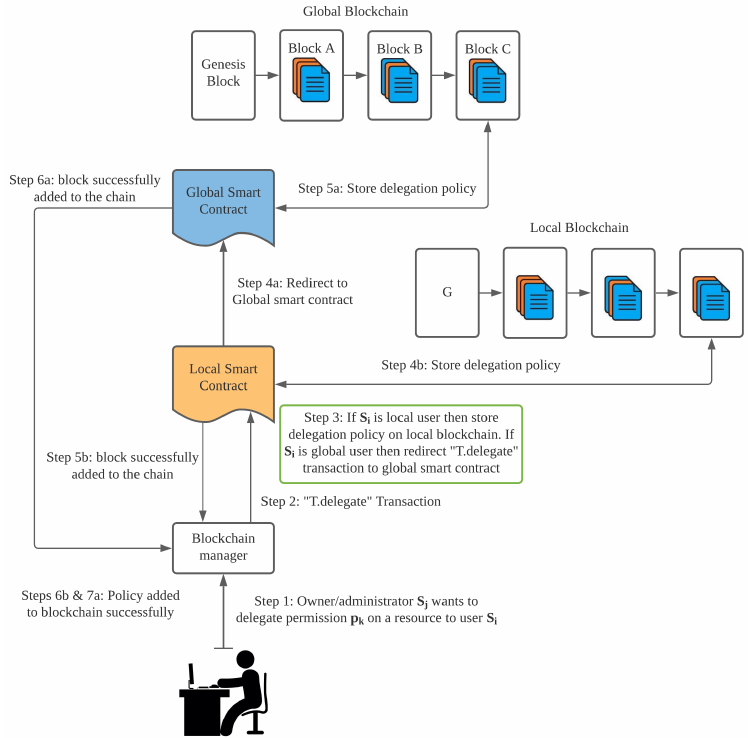
Figure 3. System